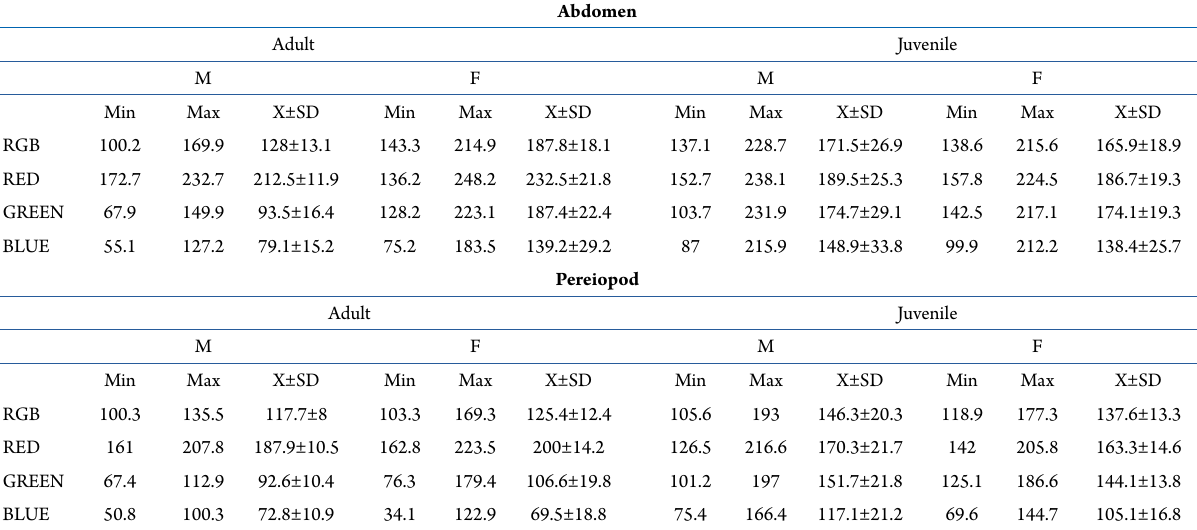
Table 4. Spectrum color values of Dilocarcinus pagei for males and females by morphological structure and developmental stage. Min. = minimum; Max. = maximum; X = mean; SD = standard